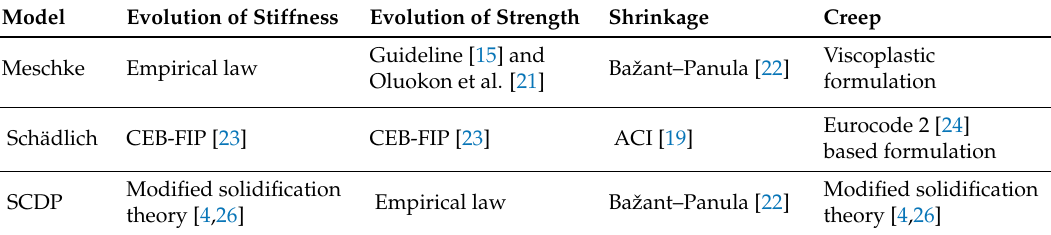
Table 3. Summary and comparison of the shotcrete